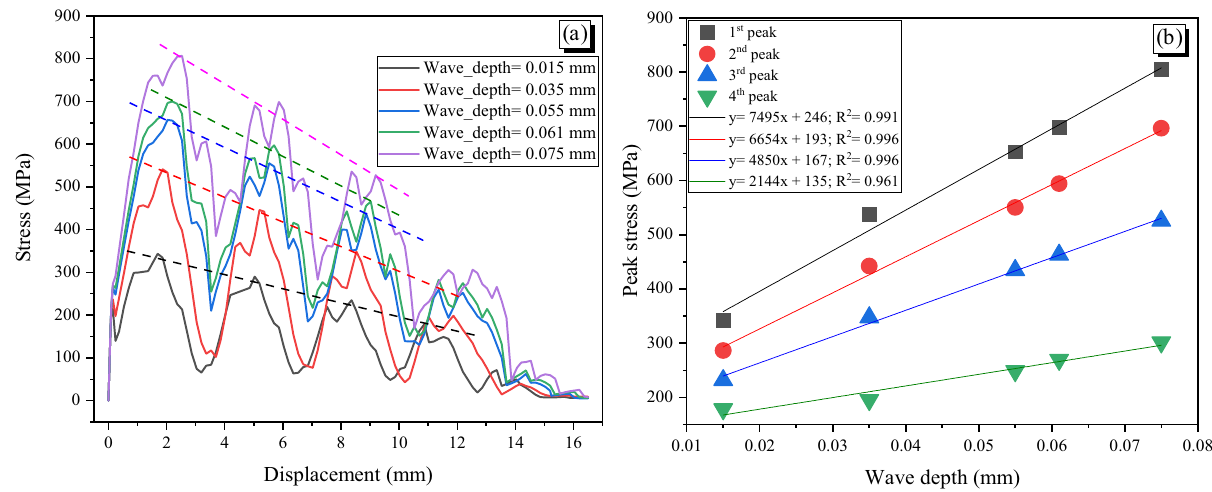
Figure 26: Relationship between pullout stress and wave depth of fi ve - wave crimped fi ber: ( a ) pullout curves and ( b ) peak stress versus wave depth.